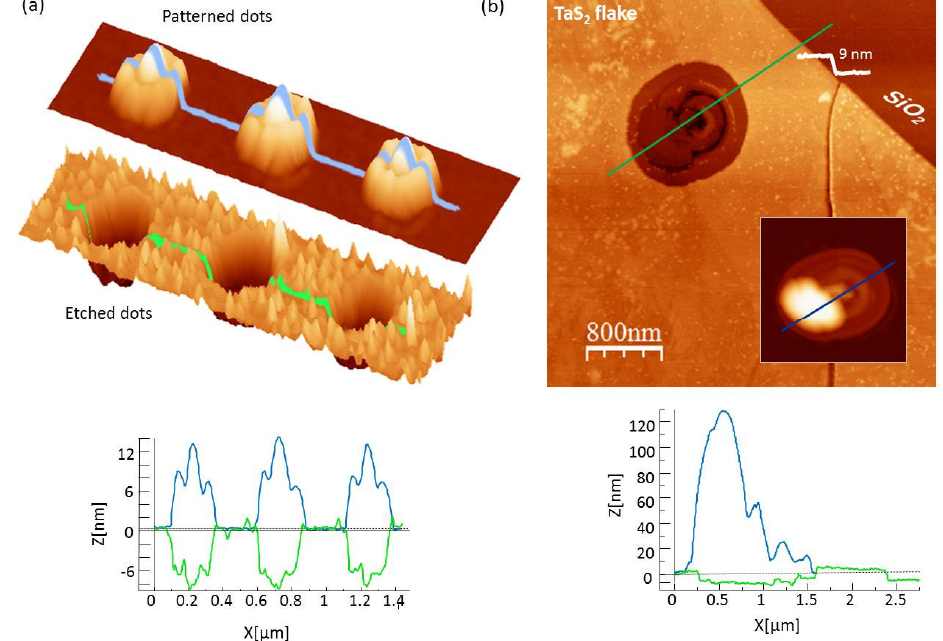
Figure 5. ( a ) Etching on a thick TaS 2 layer (bulk). 3D topography image of an array of three oxide dots created at − 22.5 V and 45 ms (top) and the same three HF etched oxide dots (bottom). Images size: 1.7 µ m × 480 nm. Below, the corresponding profiles for both images pristine (blue) and etched (green) oxide mounds are shown; ( b ) Etching on a thin layer (9 nm). AFM topography image of an etched oxide rippled dot on a TaS 2 layer. Inset: AFM topography image of the oxidized dot fabricated at − 27 V and 100 ms. Bellow, the corresponding profiles for both, oxidized (blue) and etched (green) motifs is shown.